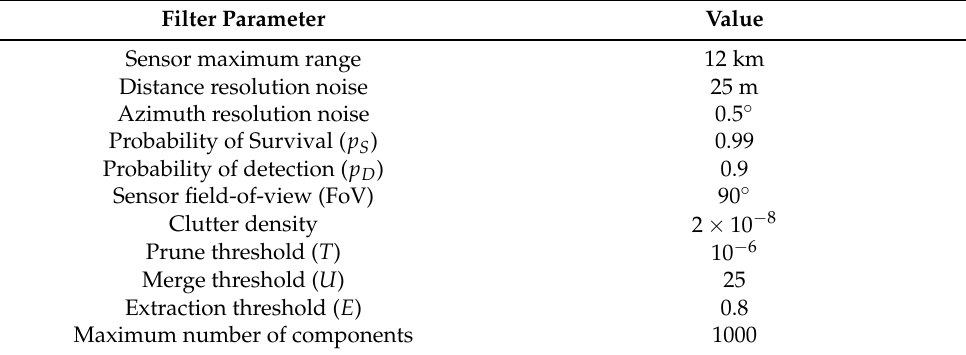
Table 3. Filter parameters used for tracking